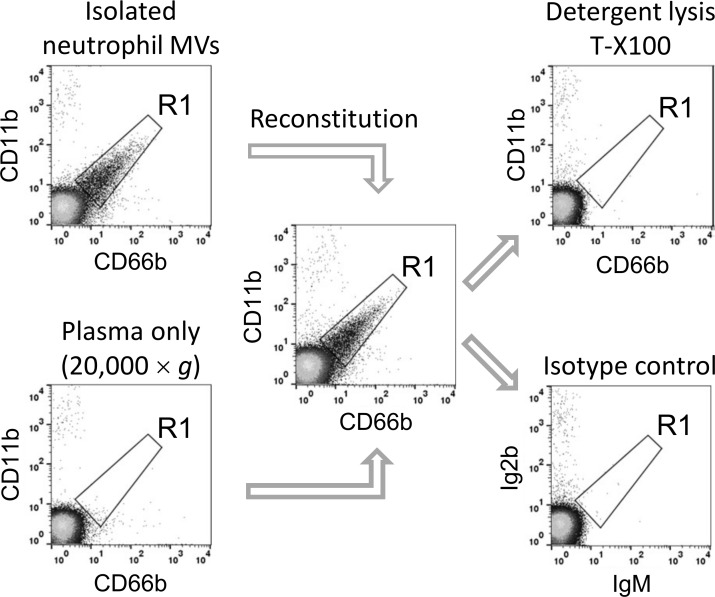
Evaluation of flow cytometry gating strategy for MVs in plasma.Suspensions of neutrophil-derived MVs and MV-depleted healthy volunteer plasma were stained with antibodies, individually or after addition of MVs to plasma (volume ratio: 1:4). Larger events were excluded using 1.3 μm beads (not shown) and a gate (R1) for neutrophil-derived MVs was drawn based on CD66b+, CD11b+ double-staining and a cut-off boundary defined by detergent-mediated selective lysis of MVs. Isotype-matched control staining provided confirmation of the detergent-lysis method for identification of non-MV background events.